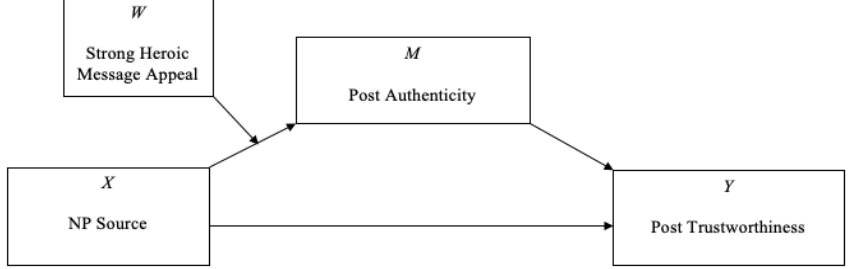
Figure 3. Illustration of the PROCESS Model 7. Nutrition professionals as the source of the Instagram post using a strong heroic message appeal was a significant predictor of post authenticity and subsequently, post trustworthiness. NP, nutrition professional. Letters ( M , W , X , Y ) are variables not abbreviations.